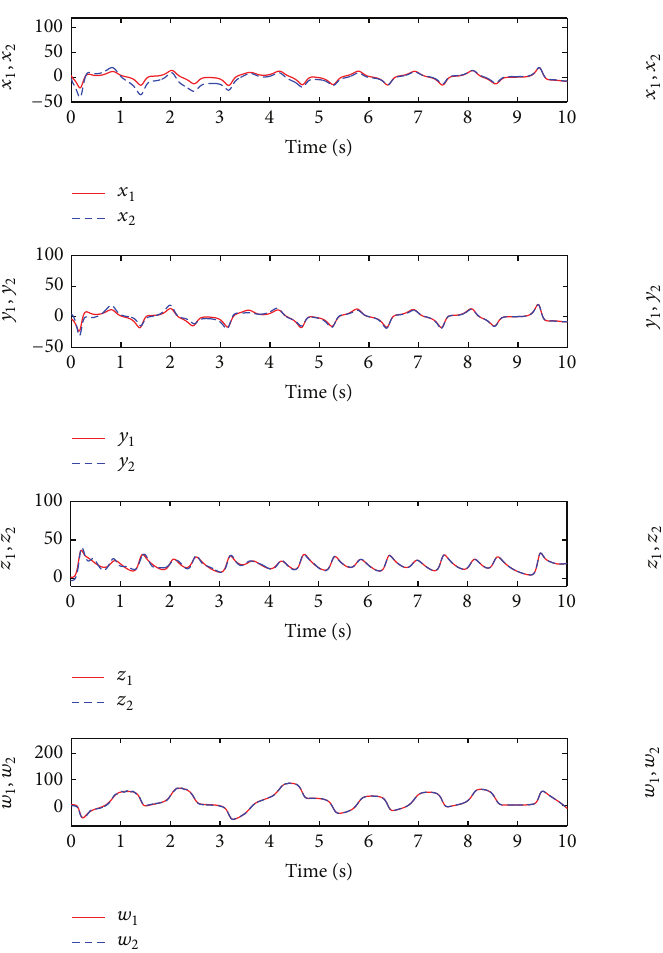
Figure 3: The states of the hyperchaotic Chen systems (5) and (6) with 𝜌 = 0.2